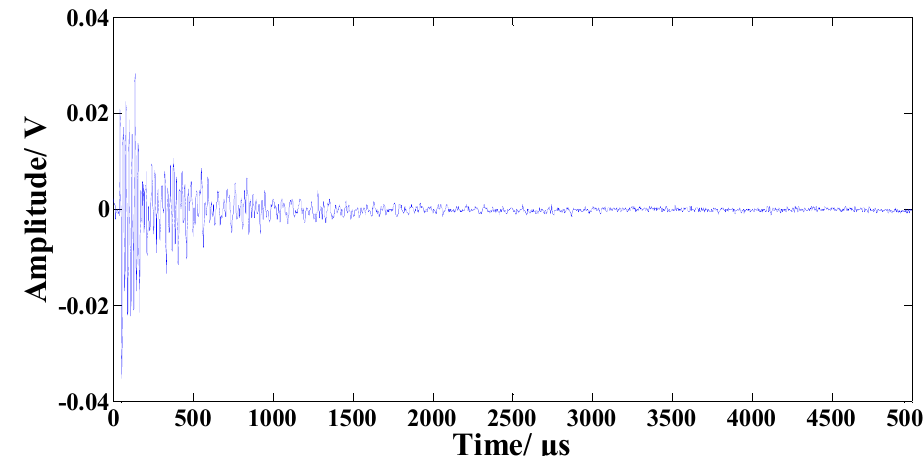
Figure 6. The processed waveform of a typical acoustic signal obtained from Q235 carbon steel in NaHCO 3 + NaCl solution (after SPI and wavelet denoising). Appl. Sci. 2018 , 8 , x FOR PEER REVIEW